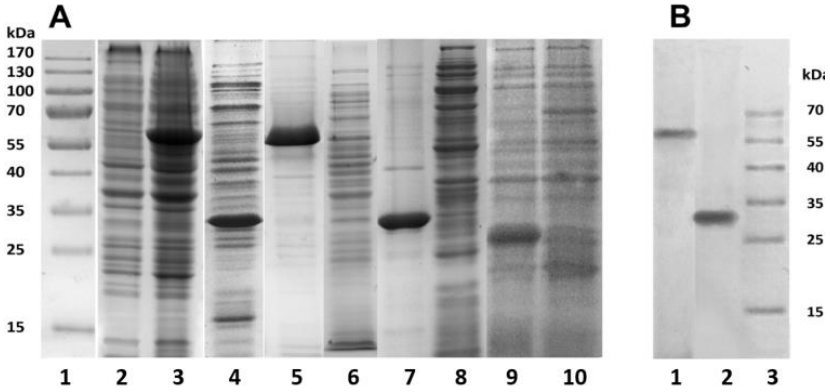
Figure 3. SDS-PAG electrophoresis ( A ) and Western blotting ( B ). ( A ): Whole cell lysates of E. coli BL plasmidless (2) and E. coli expressing PldA-GFP (3) and PldA (4); purified PldA-GFP IBs: pellet (5) and supernatant (6); purified PldA IBs: pellet (7) and supernatant (8); GFP: supernatant (9) and pellet (10); molecular weight standard (1). ( B ): PldA-GFP IBs (1); PldA IBs (positive control) (2); molecular weight standard (3). Western blotting was performed using mouse polyclonal antiserum to recombinant PldA.